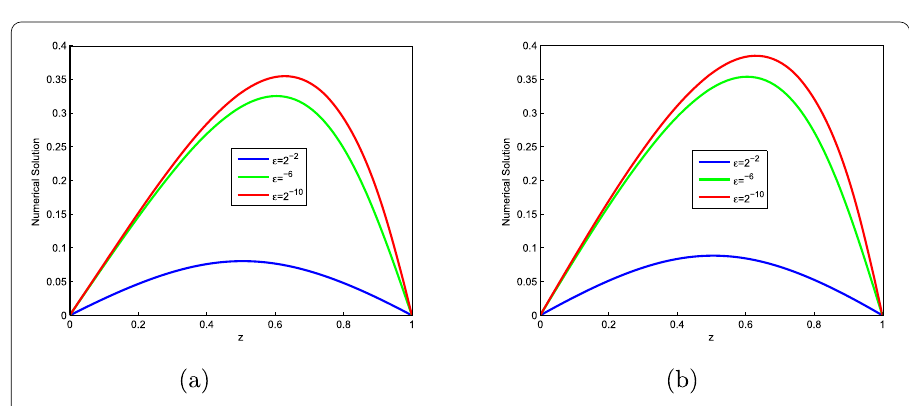
Figure 2 Effect of ε on the behavior of the solution with layer formation: ( a ) Example 5.1, ( b ) Example